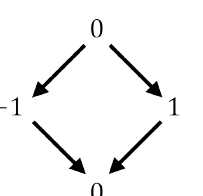
Figure 21: The representation behaves similar to ( 0 ) → ( 1 ) → ( 0 ) representation in 4 d